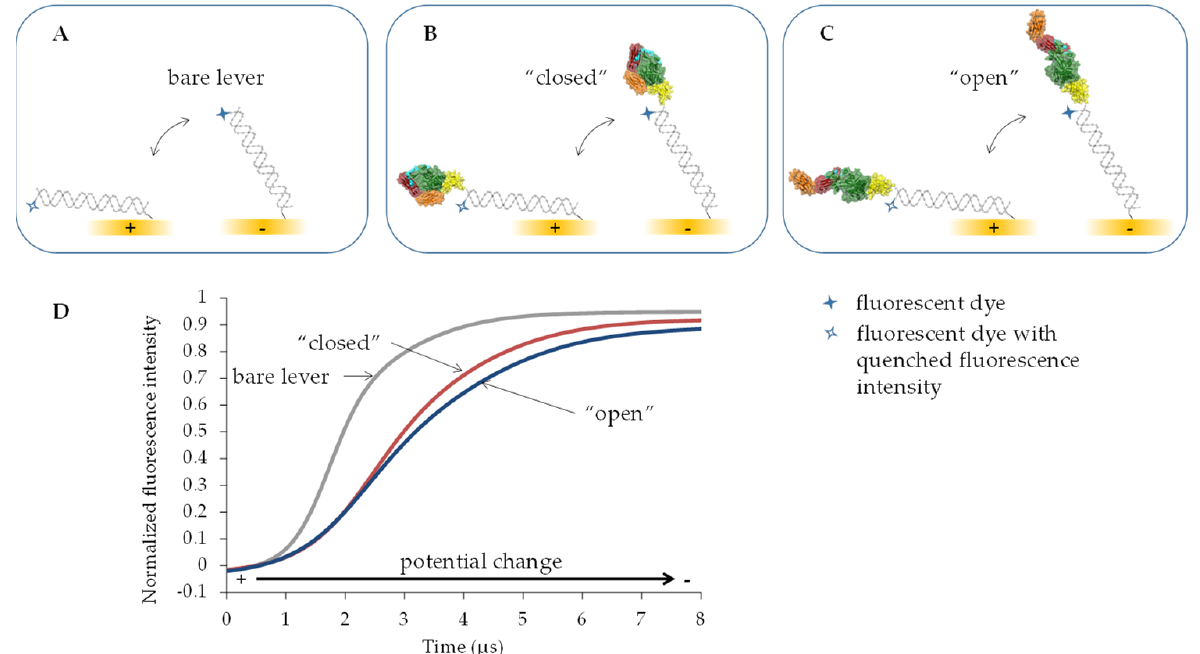
Figure 2. The switchSENSE ® principle to quantify conformational changes of TGase 2. The bare lever of double-stranded DNA of 48 base pairs length ( A ) is attracted by a positive potential, and the fluorescence intensity of the fluorescent dye is quenched due to the proximity to the gold electrode. Vice versa, the 16.3 nm-long lever is repelled by a negative potential, causing recovery of the fluorescence intensity ( D ). The lever with covalently bound TGase 2 in the “closed” conformation, with an extension of roughly 10 nm ( B ), will show increased friction during the upward motion, and consequently, slower recovery of the fluorescence intensity. An even higher friction is expected for the TGase 2 in the “open” conformation with an overall extension of roughly 15 nm ( C ). Accordingly, the maximum slope in the kinetics of the increasing fluorescence intensity can be used to quantify the extent of conformational change of the TGase 2 ( D ). For an accurate quantification, the slope in the kinetics of the bare lever is used as reference